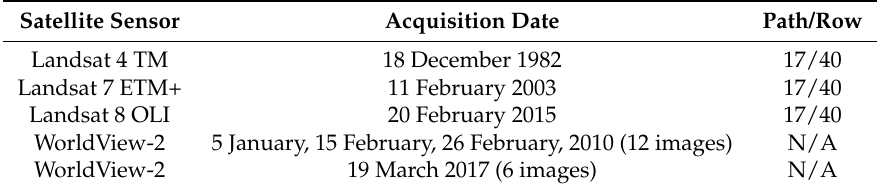
Table 1. Satellite image acquisition